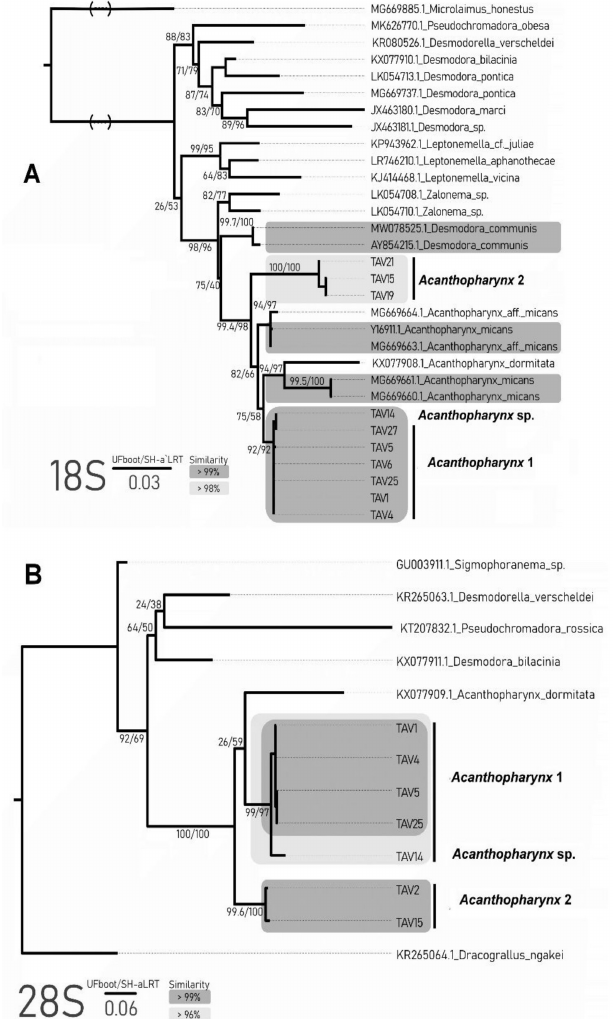
Figure 6. Phylogenetic trees based on nuclear sequences: ( A )—18S ML Phylogenetic tree. Branches are shown with the UFboot/SH-aLRT support. The sequences with similarities ≥ 98% and 90% are indicated with light and dark grey. ( B )—28S ML Phylogenetic tree. Branches are shown with the UFboot/SH-aLRT support. The sequences with similarities ≥ 96% and 90% are indicated with light and dark